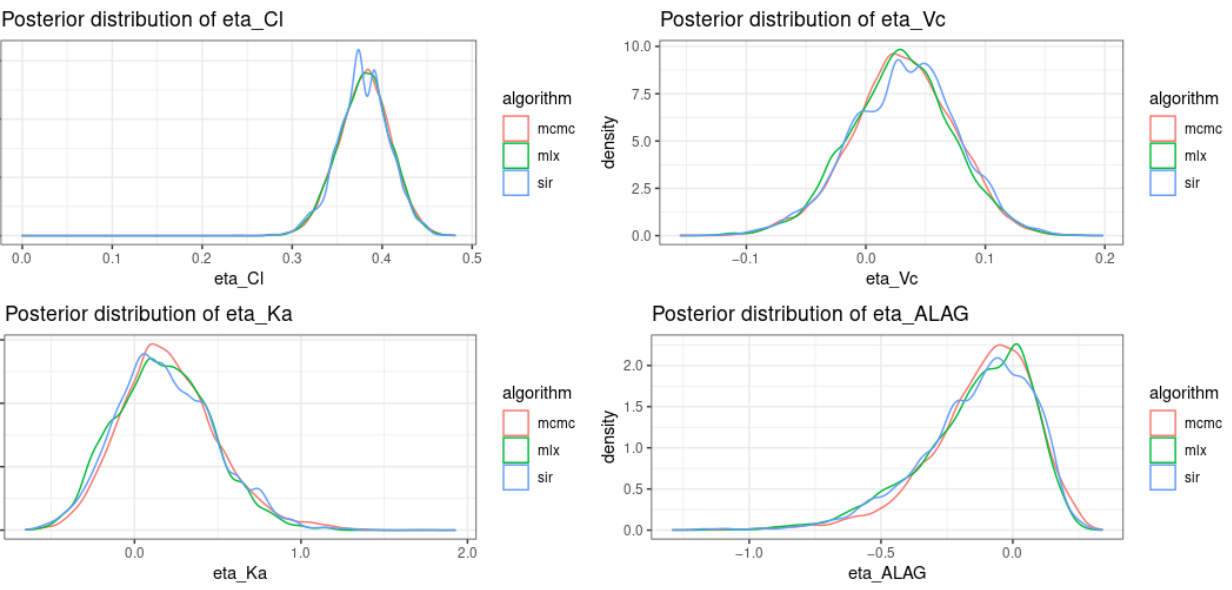
Figure 3. Adequacy of dose adaptation by tested model for a target concentration based on SIR posterior estimates. The negative percentages are the proportions of discordant propositions.